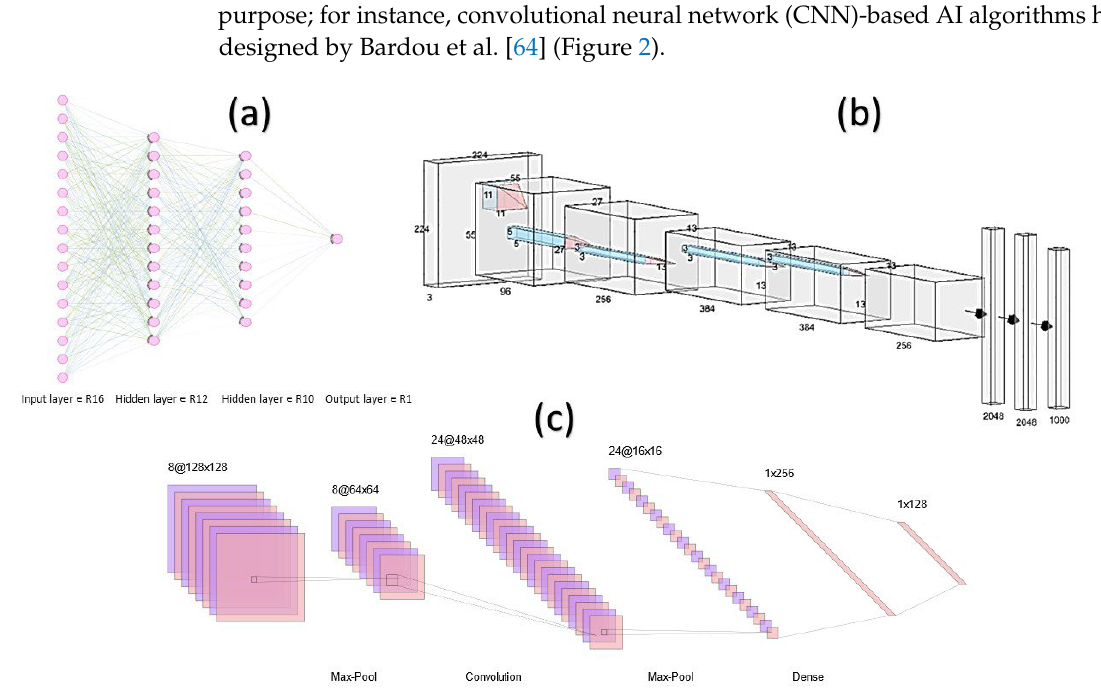
Figure 2. Different types of Neural Networks Architecture [65]: ( a ) Fully-Connected Neural Network (FCNN); ( b ) AlexNet is a Deep Neural Network [66]; and ( c ) LeNet refers to LeNet-5 and it is a simple CNN [67].